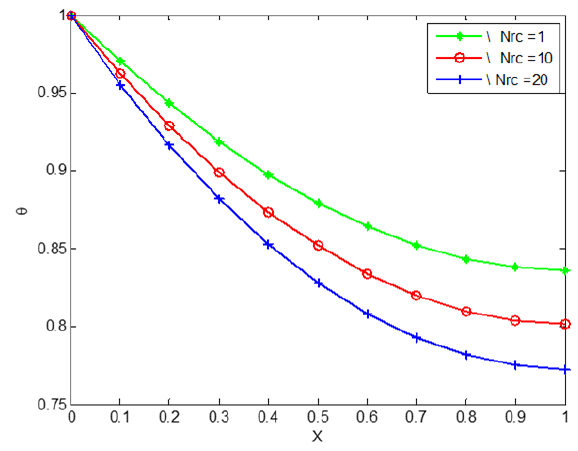
Figure 15. The effect of convective radiative parameter (Nrc) on the temperature distribution of a silicon nitride porous fin